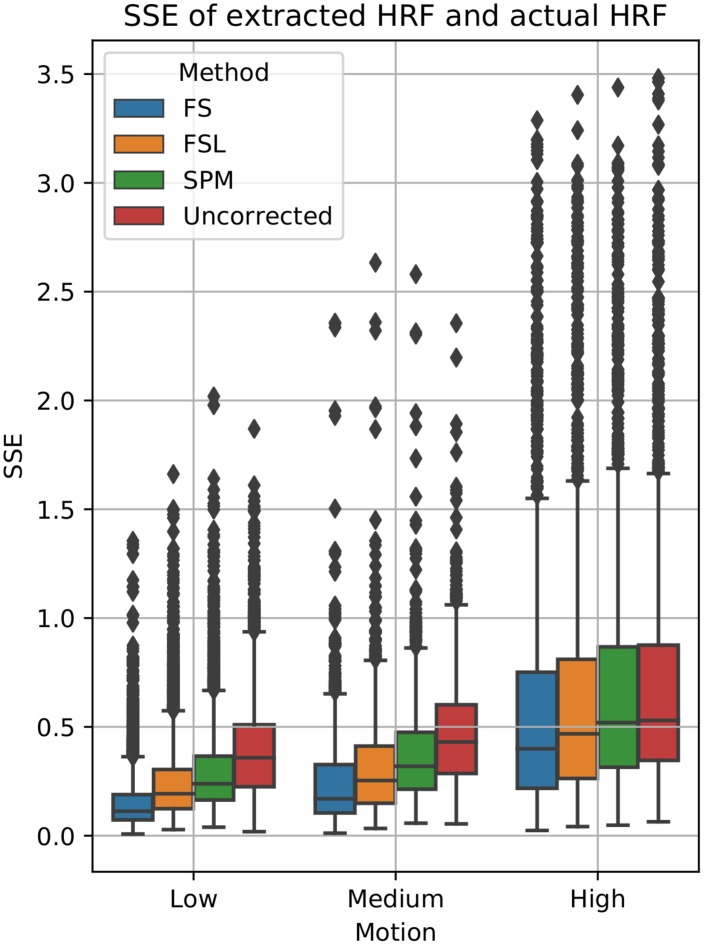
Quantification of BOLD HRF extraction error. SSE of normalized HRF’s deconvolved from STC data, compared to the canonical HRF used in the simulation for low, medium, and high motion. For each motion level and STC method, HRF SSE’s are combined across all pipeline orders.